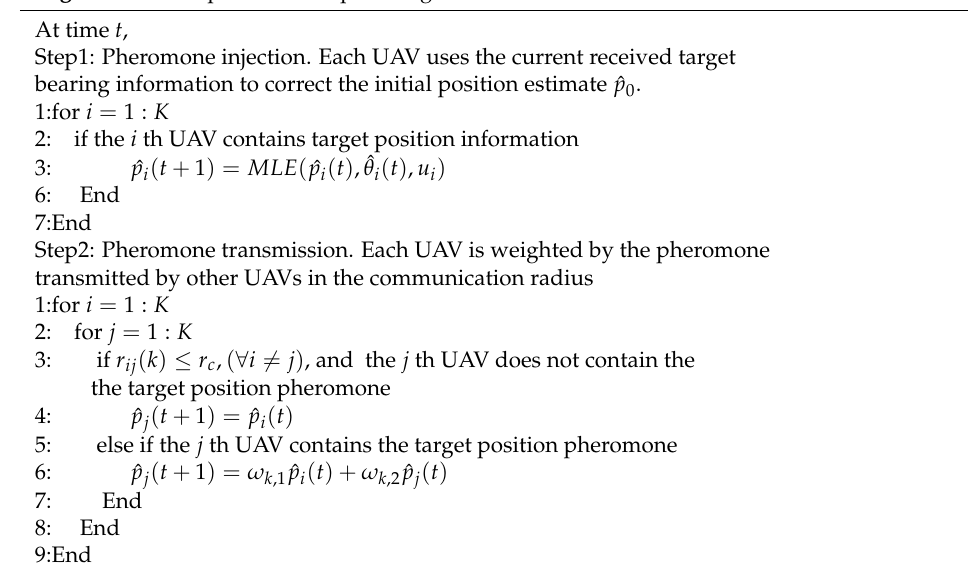
Algorithm 1 The pheromone update